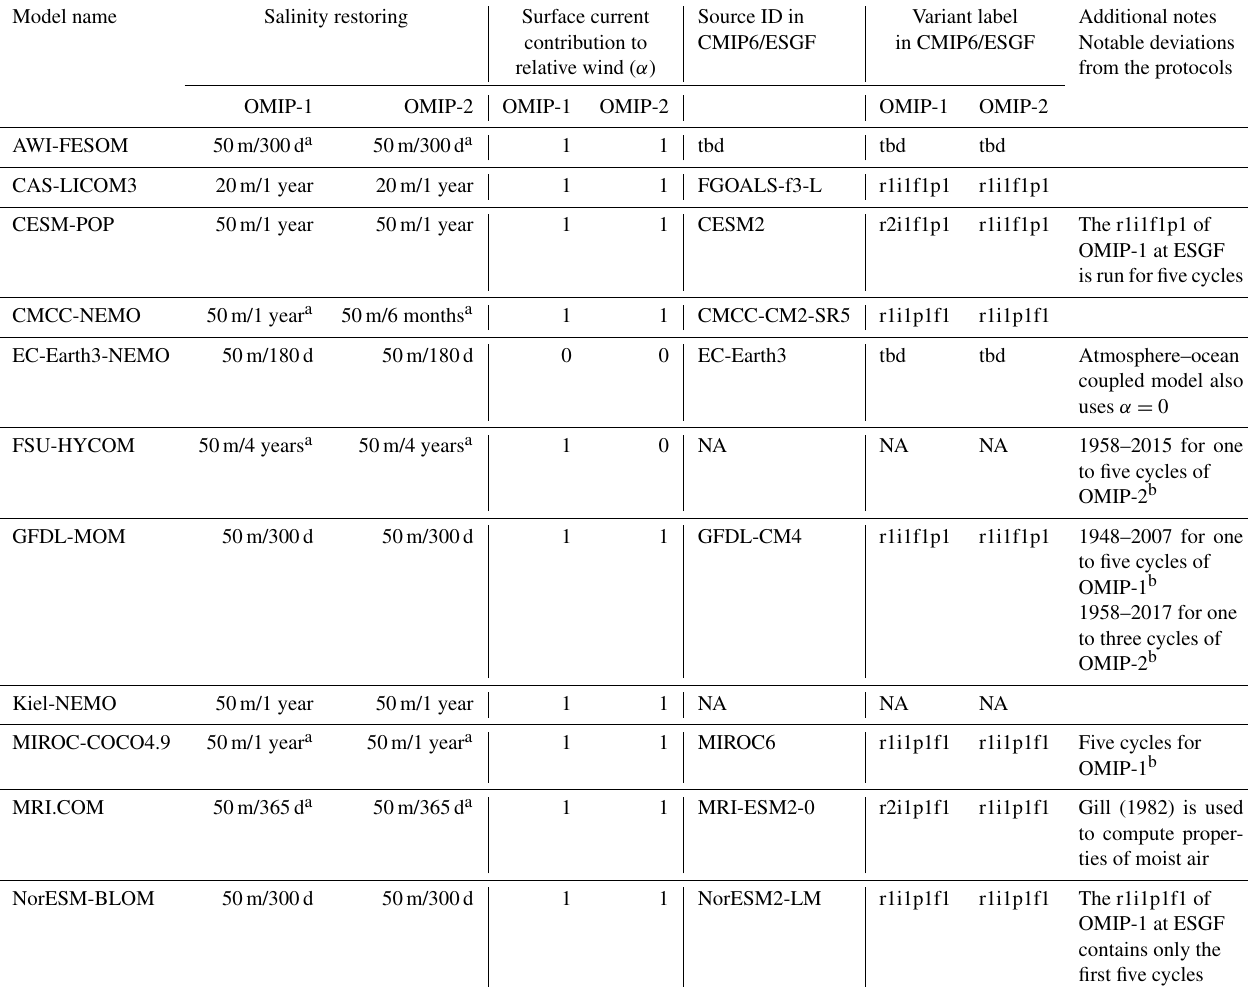
Table A1. Experimental settings and the minimum information to identify the experiments in ESGF for participating models. See Appendix A for detailed